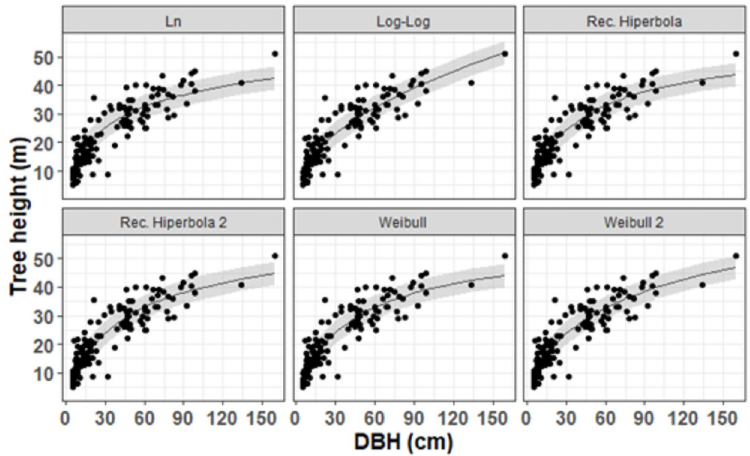
Fig 2. Estimates and prediction errors of local models adjusted for total height data in tropical forest in Amapa´.